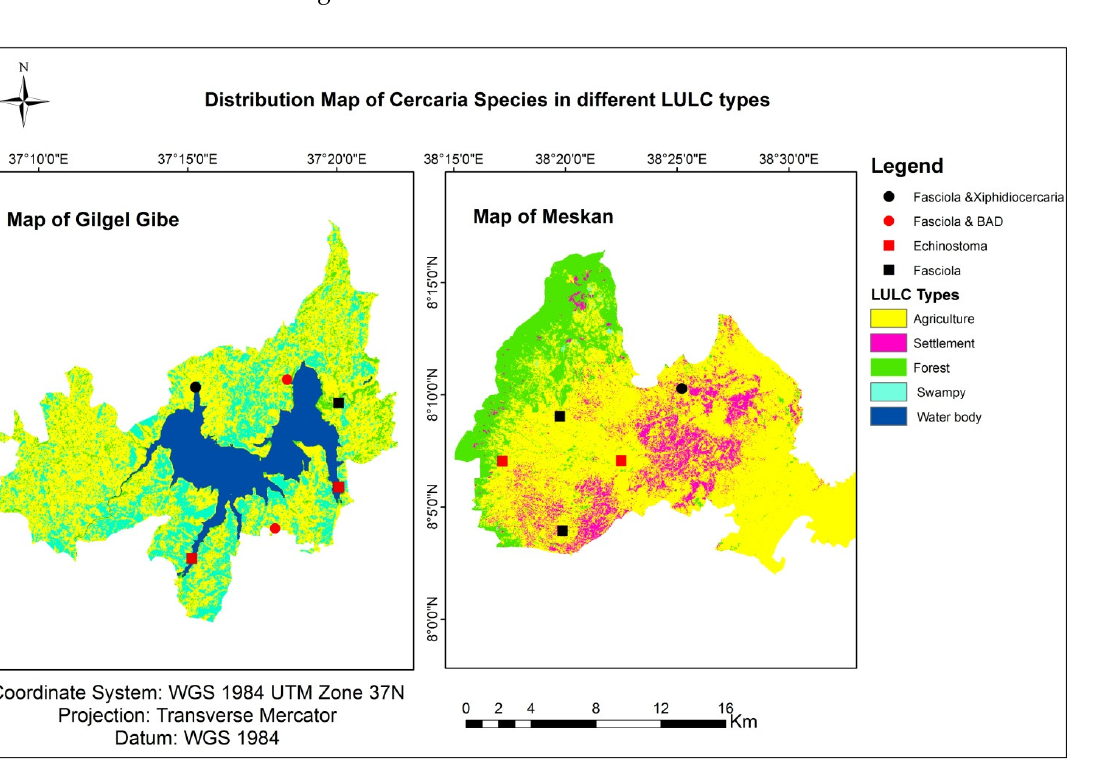
Figure 3. Cercarial infection in relation to land